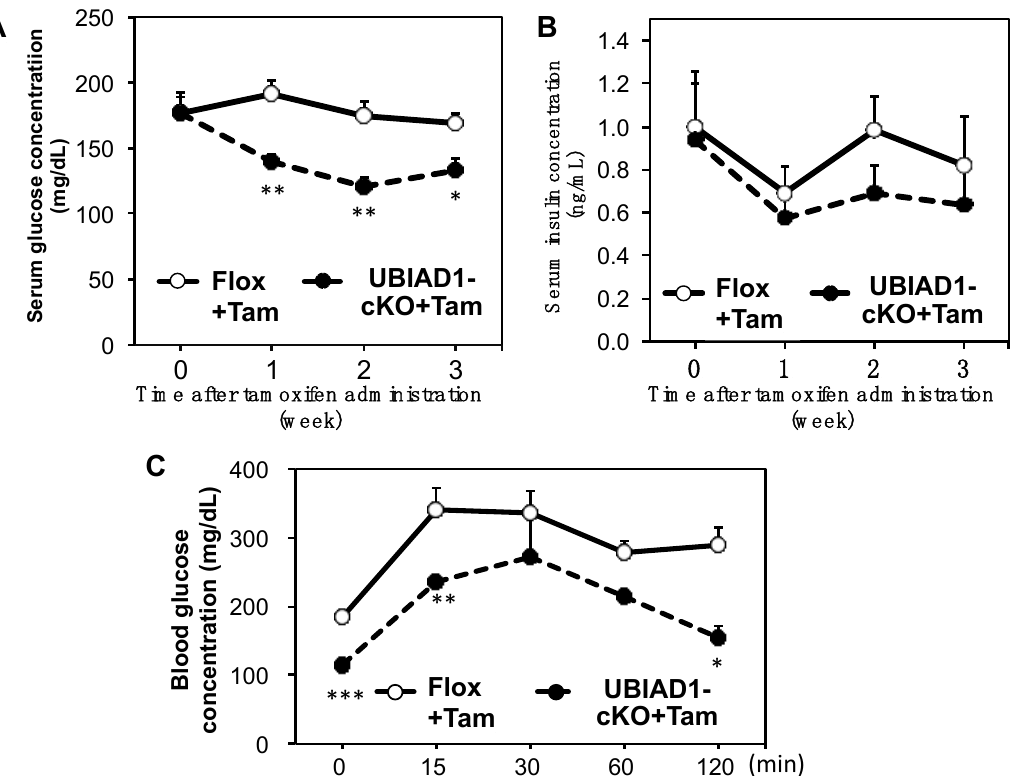
Figure 8. Serum glucose ( A ) and insulin ( B ) concentrations in Flox and UBIAD1-cKO mice after tamoxifen administration. Oral glucose tolerance test ( C ) in tamoxifen-treated Flox and UBIAD1-cKO mice at 40 days after administration of tamoxifen. Serum glucose was assayed at 0, 15, 30, 60, and 120 min. Each point on the curve represents the mean ± SEM. Data are shown as means ± SEM; * p < 0.05 and ** p < 0.01 when compared with the corresponding values at each point in the tamoxifen-treated Flox mice.